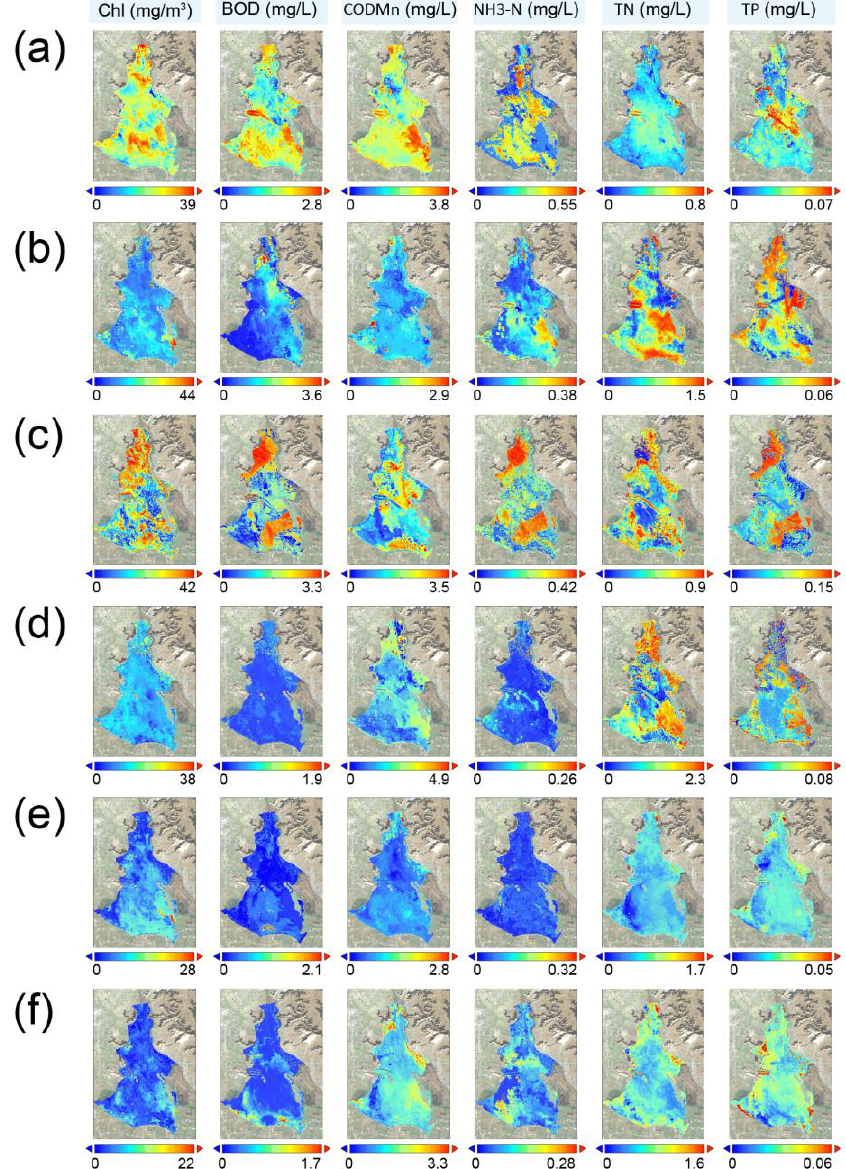
Figure 5. Maps for the estimated water quality variables for Dongping Lake on 2013.11.29 ( a ), 2014.7.11 ( b ), 2015.5.18 ( c ), 2016.9.2 ( d ), 2017.11.24 ( e ) and 2018.4.17 ( f ).